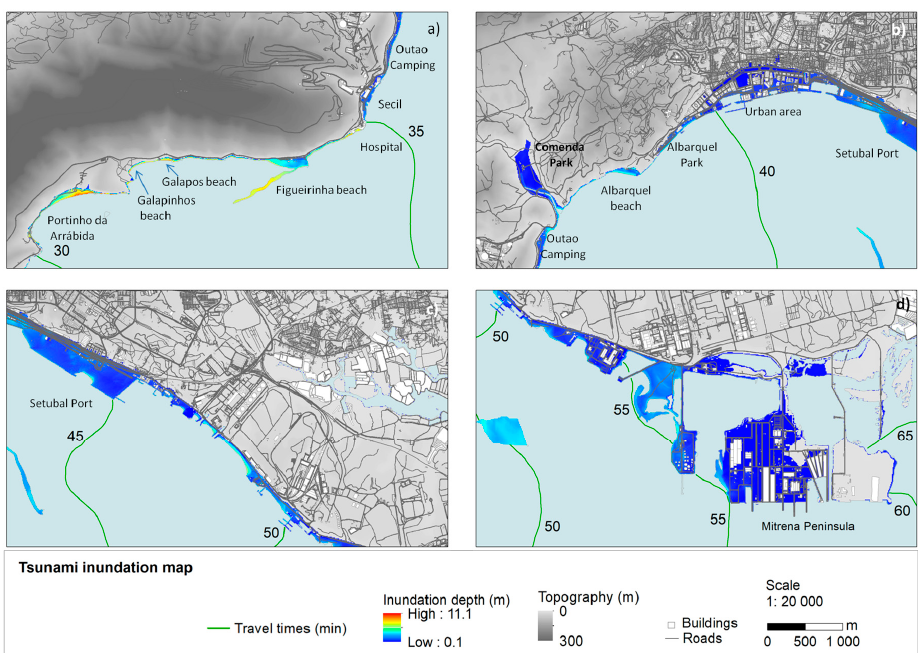
Figure 13. Inundation map due to the 1755 tsunami. Tsunami travel times represent elapsed time since earthquake, in minutes: ( a ) Western area; ( b ) Central area, including the urban area; ( c ) Eastern area, including the industrial area; ( d ) South-east area where the Mitrena Peninsula is located.